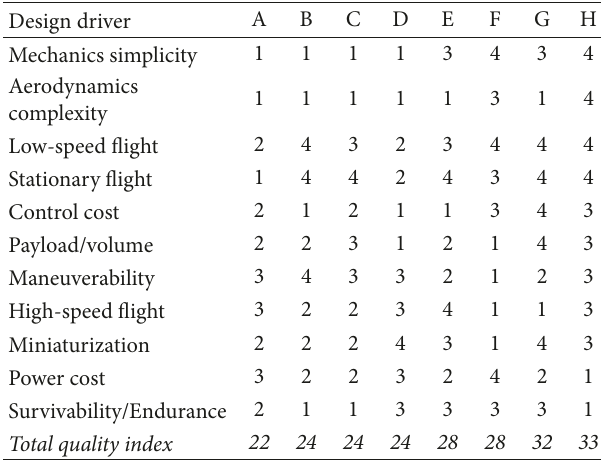
Table 2: Comparison among different VTOL concepts and design issues (see text for explanation).